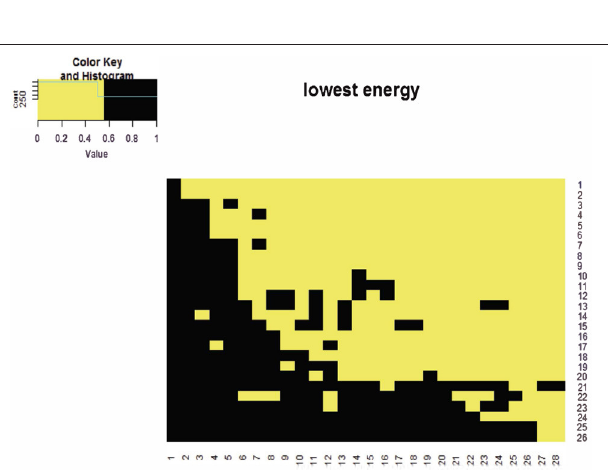
FIGURE 2 | The heatmap of a binary matrix for the mammalian dataset. This binary matrix has the lowest energy given that the row and column sums are